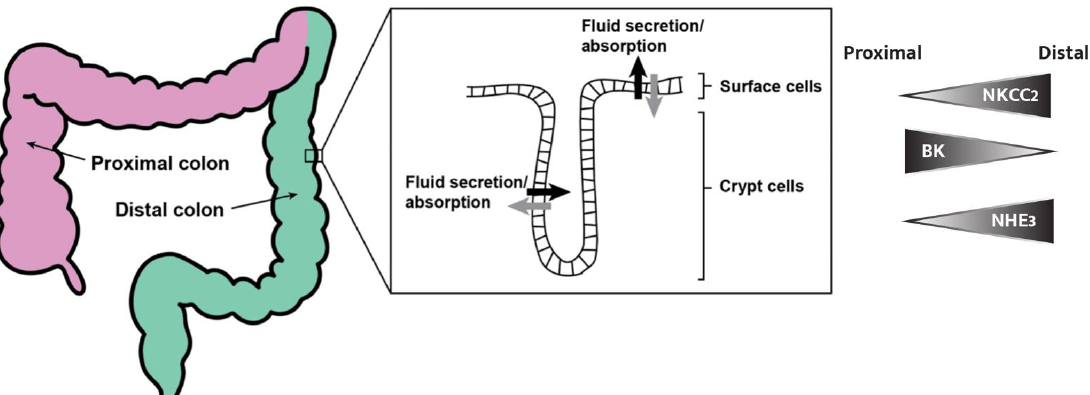
Figure 1. Schematic model of the colon and crypt. We refer to everything from the cecum to the left colic flexure as the proximal colon (pink) and everything spanning from the proximal colon to the perianal junction as the distal colon (green). An expansion of the luminal colonic epithelium (right) shows the crypt – surface cell axis and a model for fluid secretion and absorption, where both cell types secrete and absorb fluids and electrolytes [4]. The right panel shows an intensity profile graphic representing the distribution of NKCC2, BK channels, and NHE3 (transport proteins described in more detail later in this review) from the proximal to distal colon.